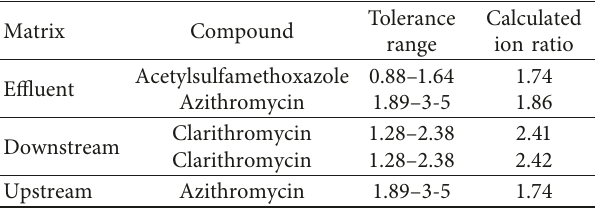
Table 7: Compounds with ion ratios detected outside the set tolerance range of 40% for WWTP influent samples and 30% for WWTP effluent, upstream, and downstream samples. ±